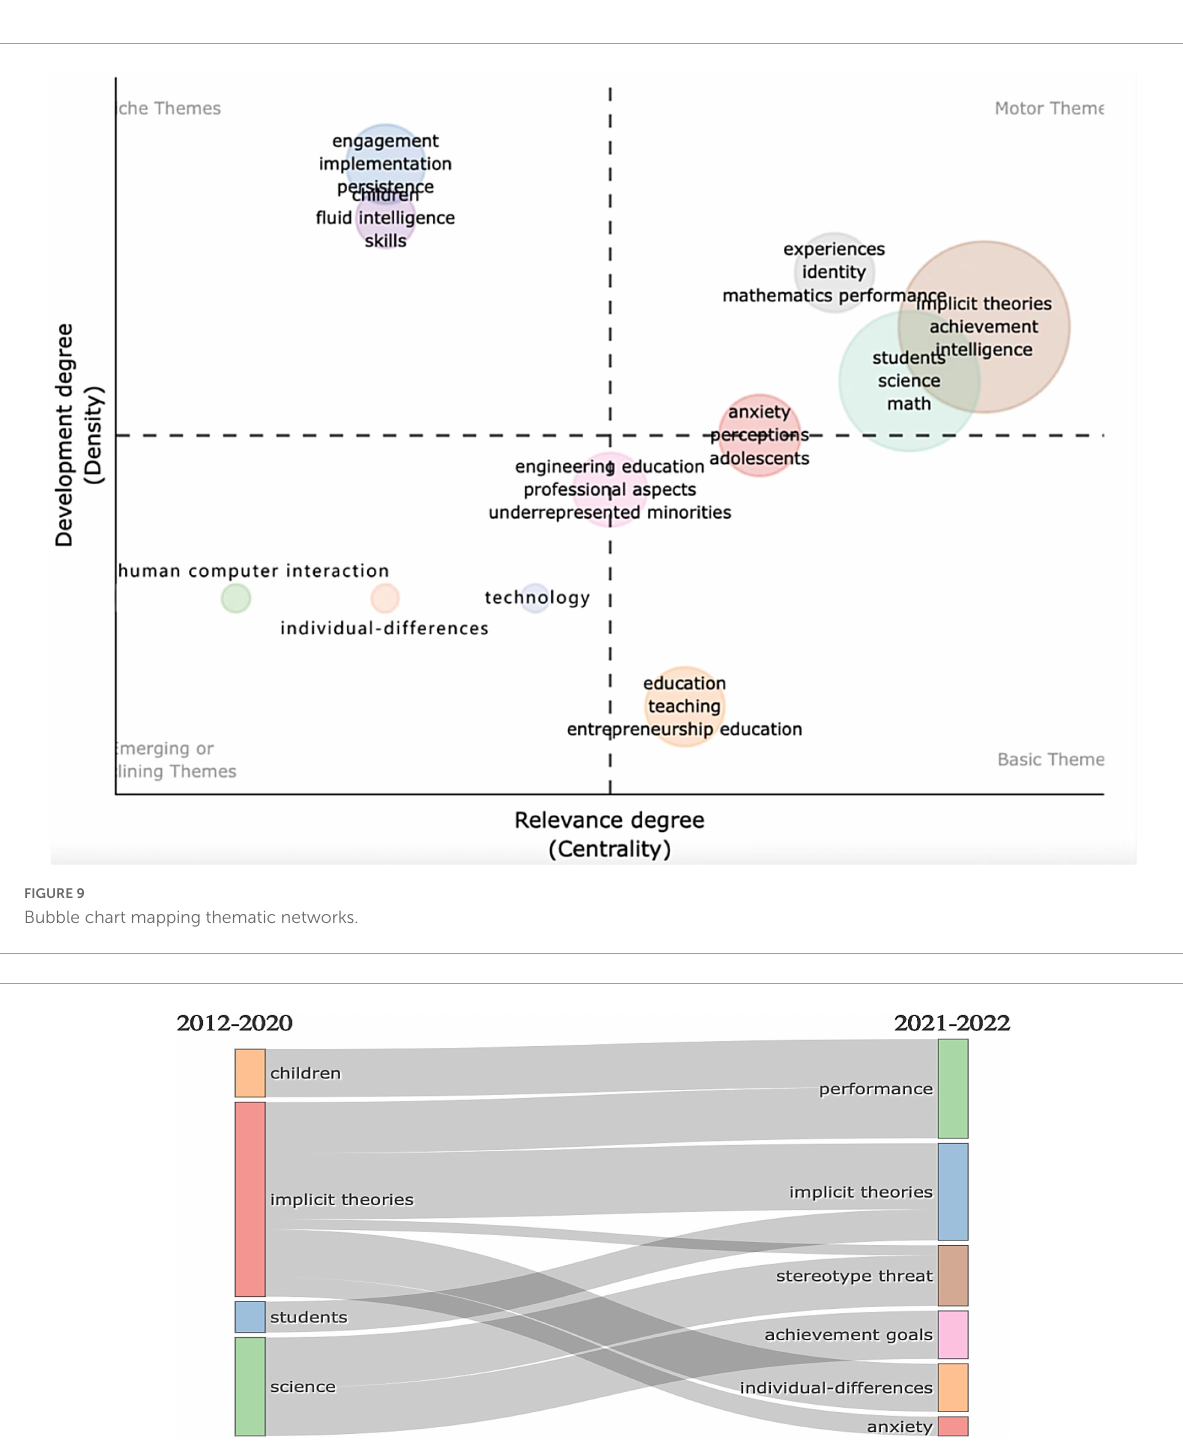
FIGURE10 Flow diagram of longitudinal thematic